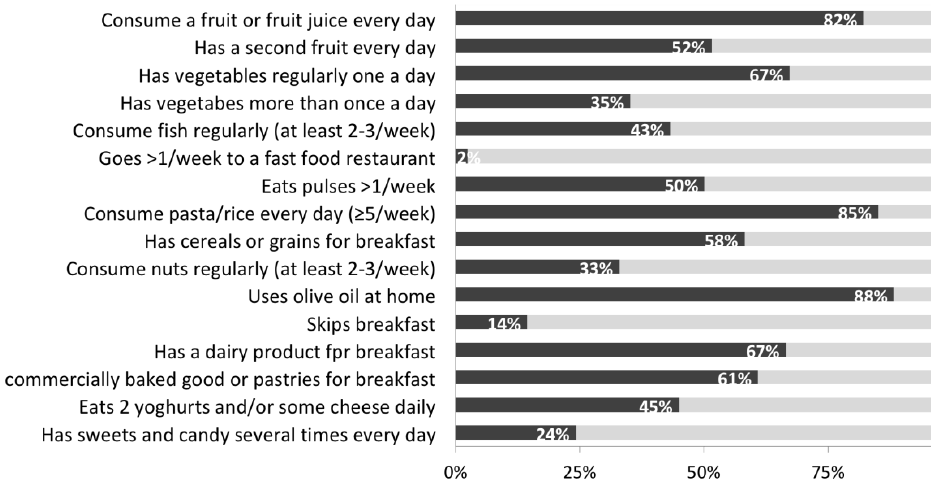
Figure 1. Responses to the KIDMED questionnaire (Mediterranean Diet Quality Index in Children and Adolescents) for the total sample.